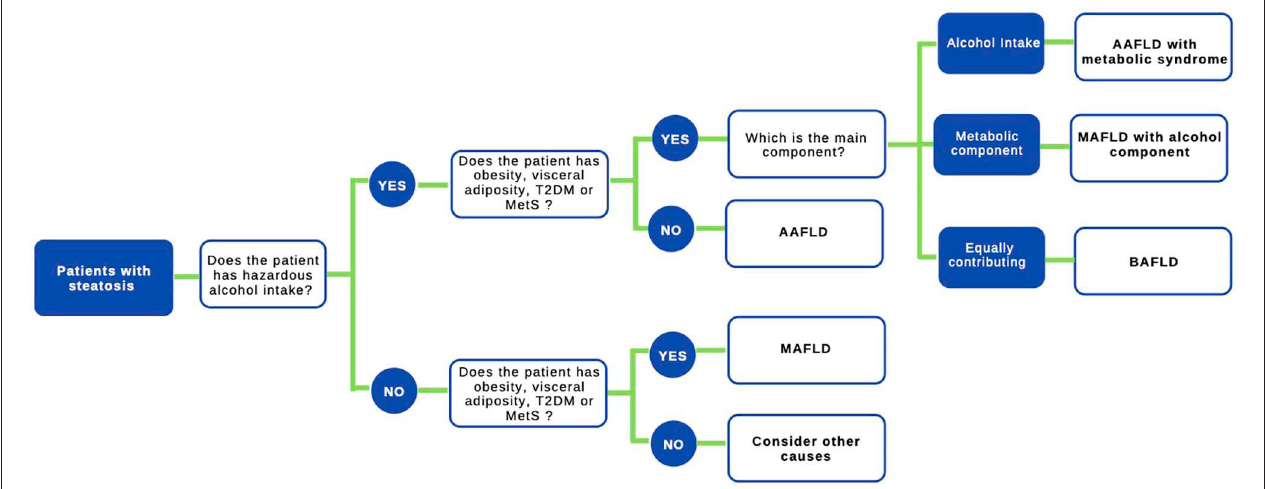
FIGURE 2 | Proposed algorithm to approach patients with liver steatosis. A staggered algorithm to approach patients with liver steatosis is shown. This algorithm considers alcohol intake and metabolic cofactors (obesity, T2DM, and MetS) and classifies patients in AAFLD alcohol-associated fatty liver disease (true ALD) if hazardous alcohol intake is present, AAFLD with metabolic component (predominant ALD but with metabolic cofactors), MAFLD metabolic associated fatty liver disease (NAFLD with alcohol consumption near zero), MAFLD with alcohol component (NAFLD but with alcohol consumption contributing to the disease process), and finally BAFLD both alcohol and metabolic associated fatty liver disease (patients with both NAFLD and ALD equally contributing or no possible to determine which predominates). Criteria to diagnose MAFLD are suggested in ( 72) in the main